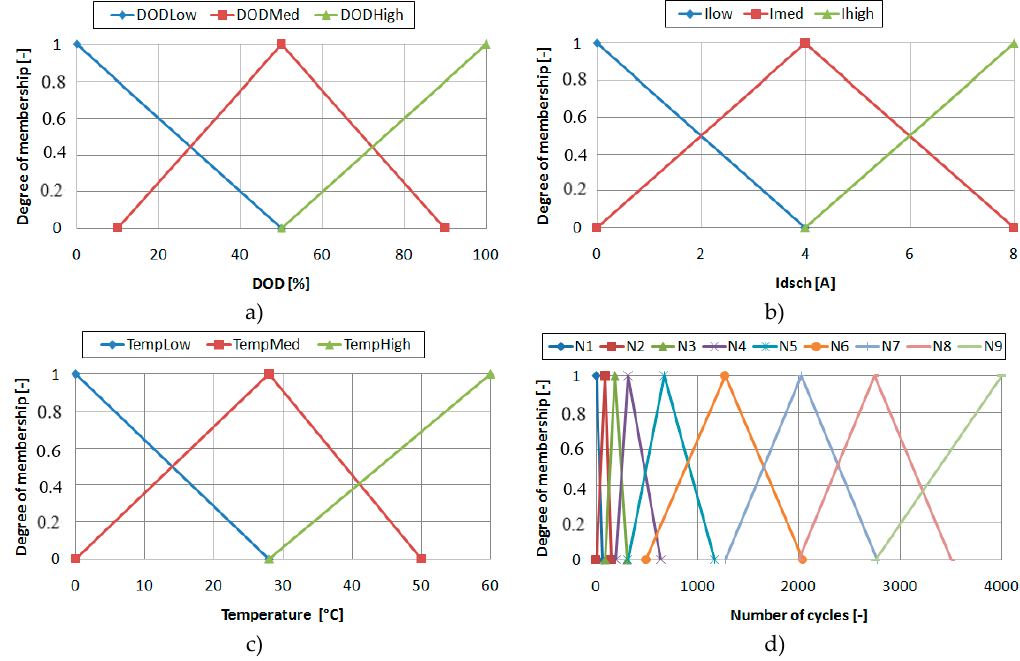
Figure 6. Membership functions of model parameters: ( a ) depth of discharge, ( b ) discharging current, ( c ) temperature, and ( d ) number of cycles.